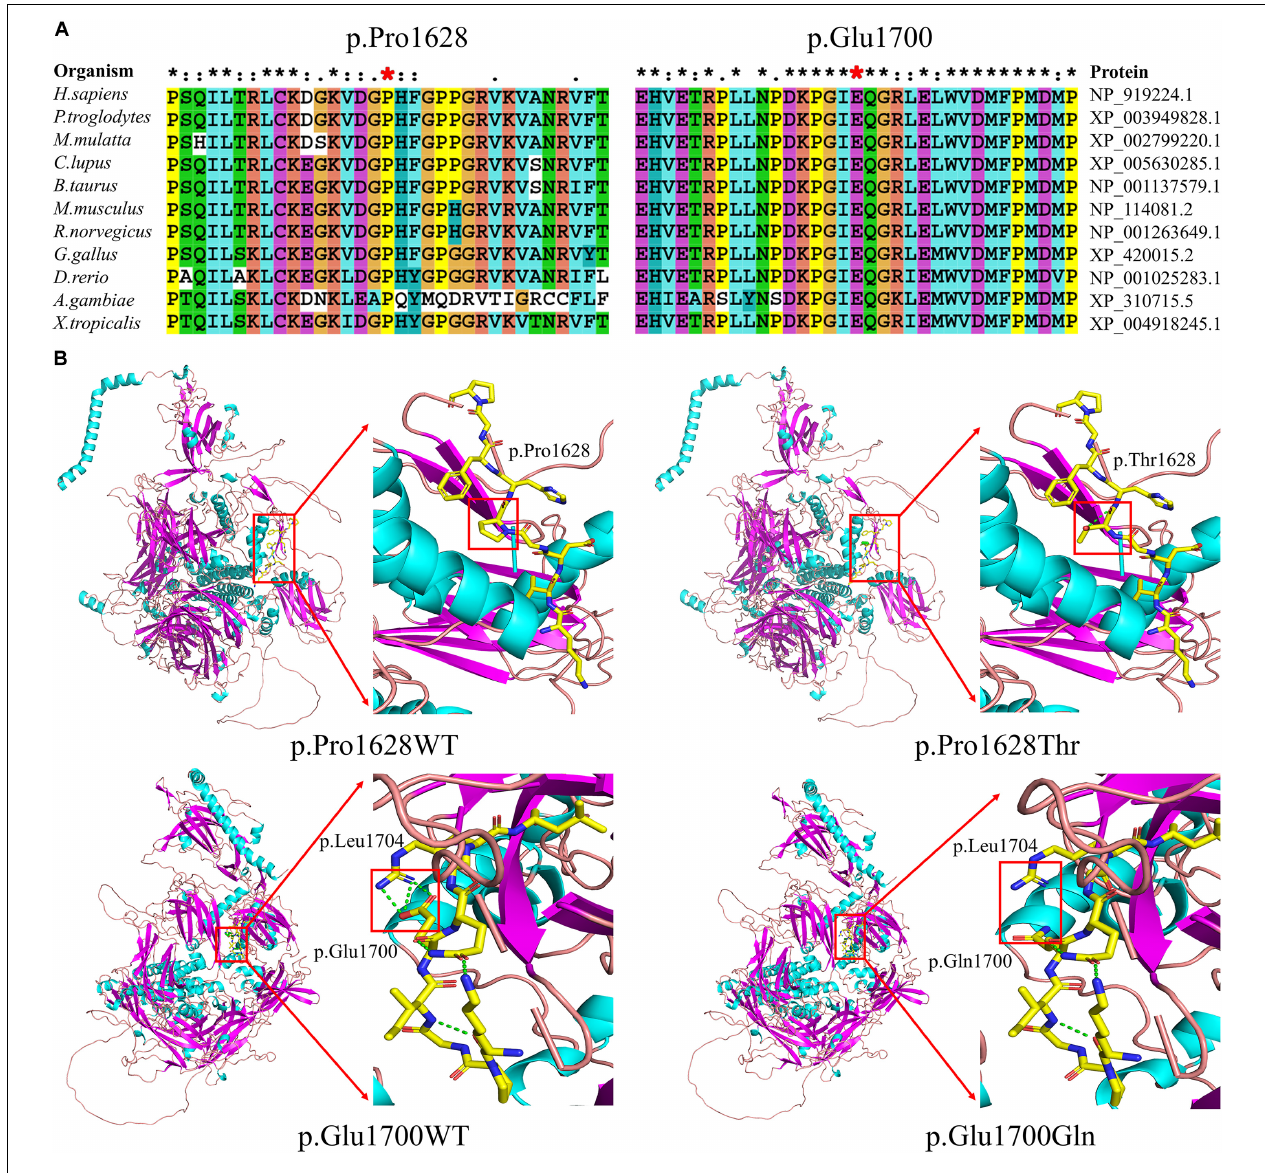
FIGURE 5 | Results of evolutionary conservation and molecular model analyses. (A) Amino acid conservation analysis. Protein alignment shows that the Pro1628 (left) and Glu1700 (right) residues of otoferlin are highly conserved across 11 organisms. The two positions of Pro1628 and Glu1700 are indicated by red stars. (B) Molecular models of wild-type (WT) (left column) and missense variants (right column) in otoferlin. The variant p.Pro1628Thr was found to perturb an amino acid chain and generate an extra hydrogen bond within the mutant p.Thr1628 (upper row) . The variant p.Glu1700Gln likely perturbs an amino acid side chain and has lost the hydrogen bonds between p.Glu1700 and p.Leu1704 (lower row) .